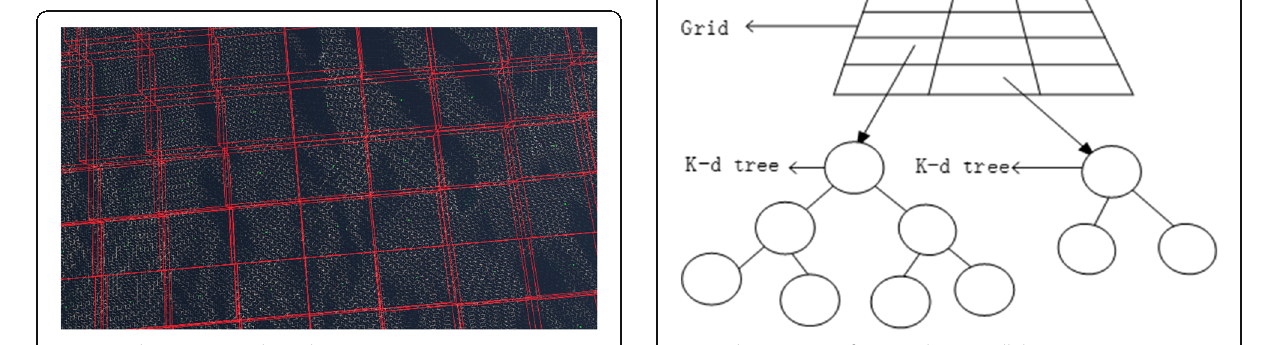
Fig. 2 Meshing in a virtual simulation system Fig. 3 The structure of sectional static